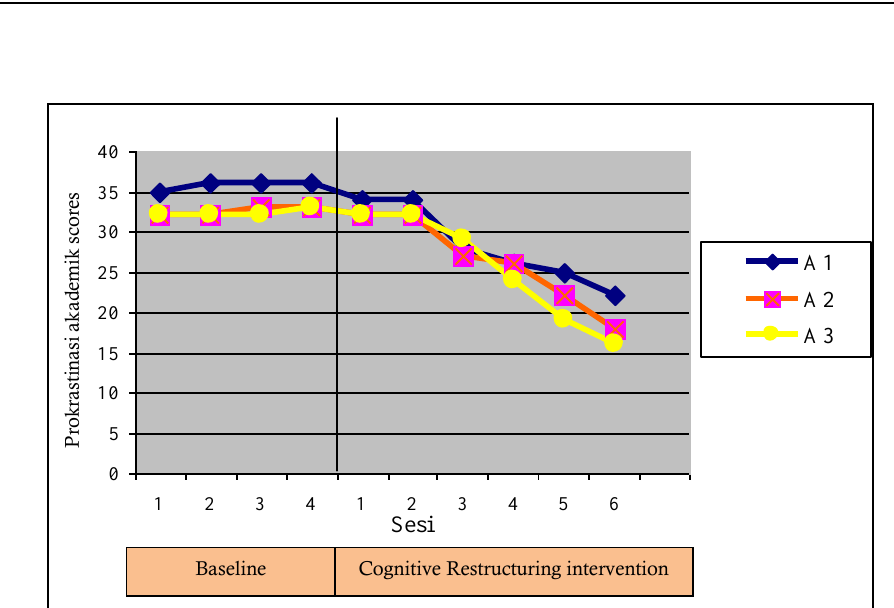
Figure 1 Graph of academic procrastination